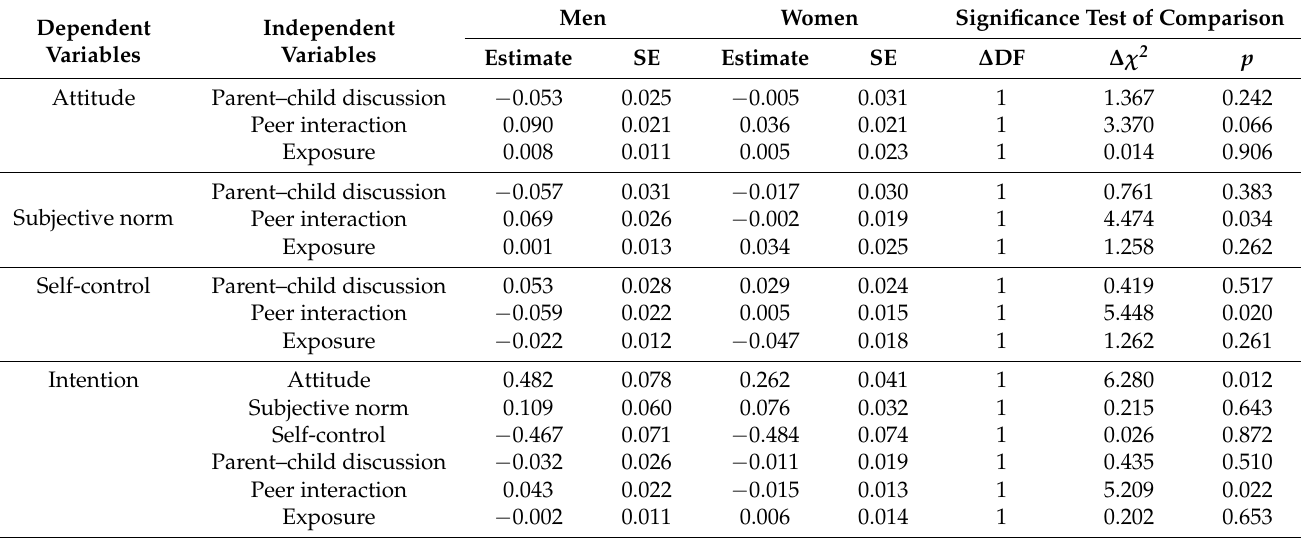
Table 5. Comparison of the paths between the models among men and women.